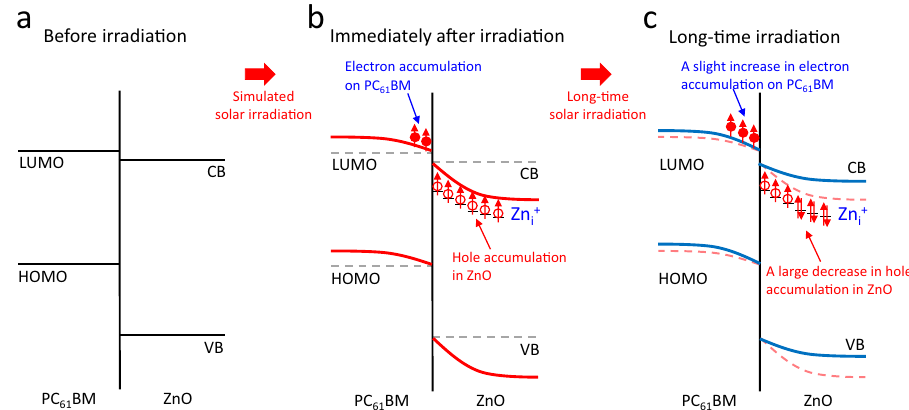
Fig. 8 Schematic variation of the interface energy level between PC 61 BM and ZnO under solar irradiation. a Before solar irradiation, electrons and holes are not trapped on PC 61 BM and in ZnO so the anion signal of PC 61 BM (Signal 2) and the hole signal of ZnO ( Zn þ Signal 4) are not observed. b Immediately after solar irradiation, a large number of electrons and holes are suddenly trapped at the interface between PC 61 BM and ZnO layer. c After long-time solar irradiation, the N spin of holes in ZnO (Signal 4) has massively